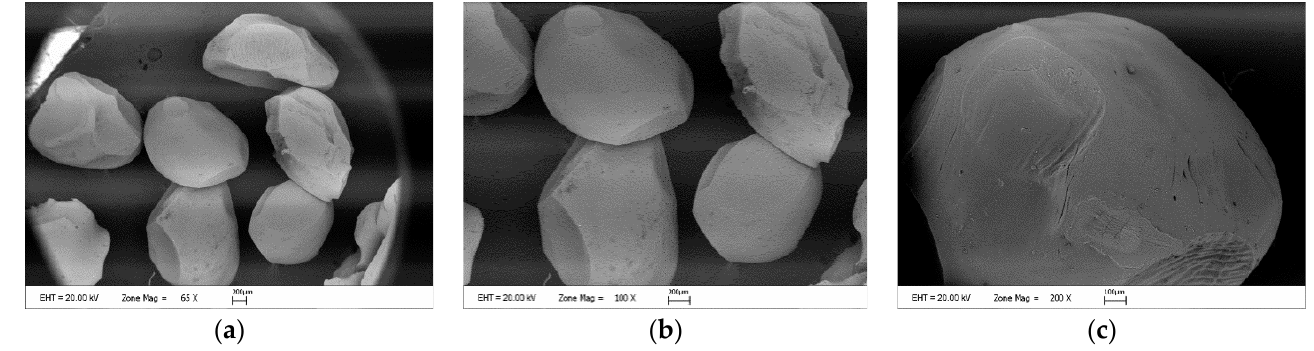
Figure 7. Scanning electron microscopy images of the alginate microcapsules with a different scale as × 65 ( a ), × 100 ( b ) and × 200 ( c